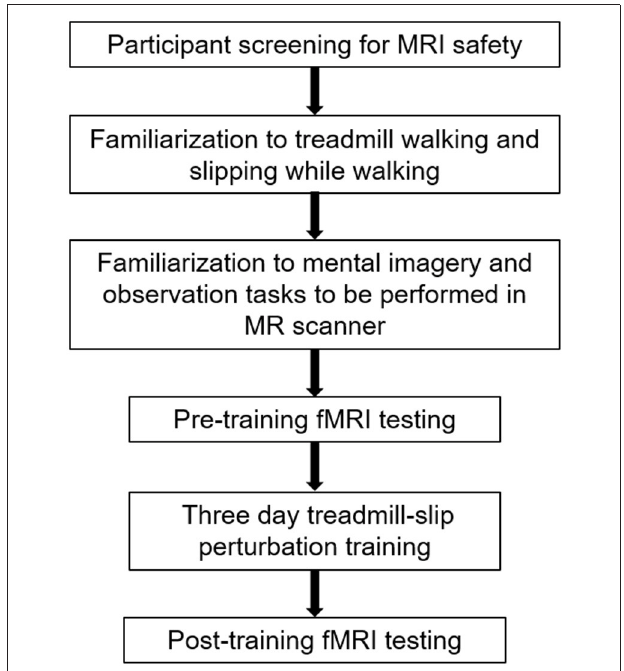
FIGURE 1 | A schematic representation of the experimental protocol. The initial session in the experimental protocol comprised participant screening